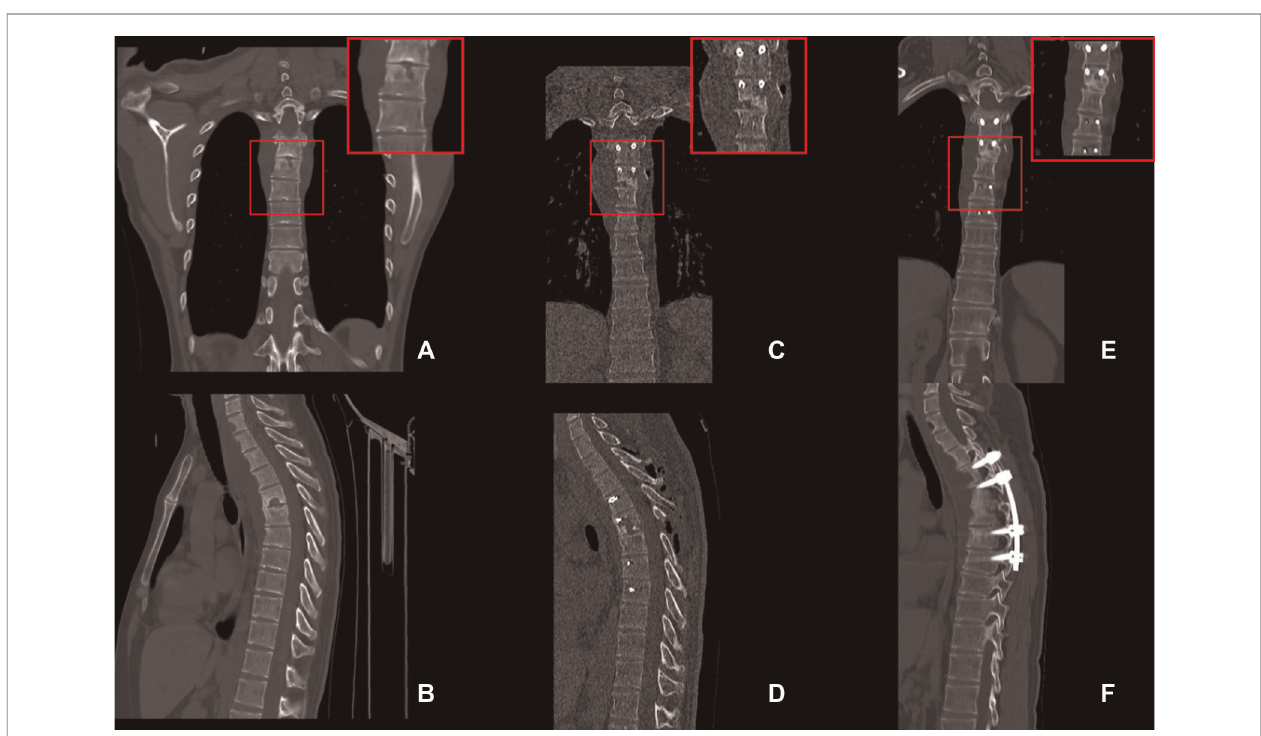
FIGURE 2 | Images for selected typical case. A 32-year-old male patient was diagnosed with thoracic vertebral tuberculosis and underwent posterior spinal tuberculosis debridement, bone grafting, fusion, and internal fi xation in our hospital ( Figure 2 ). The patient had no osteoporosis and did not take medication regularly one year after surgery. ( A / B ) A are the preoperative CT scan of the thoracic spine showed bone destruction in the thoracic spine. ( C/D ) Postoperative CT scan of the thoracic spine showed that the bone graft exhibited good contact with the upper and lower vertebral bodies. ( E/F ) Plain CT scan of the thoracic spine at the 1-year follow-up. There is a clear boundary between the bone graft and the autologous bone, and the bone graft is not